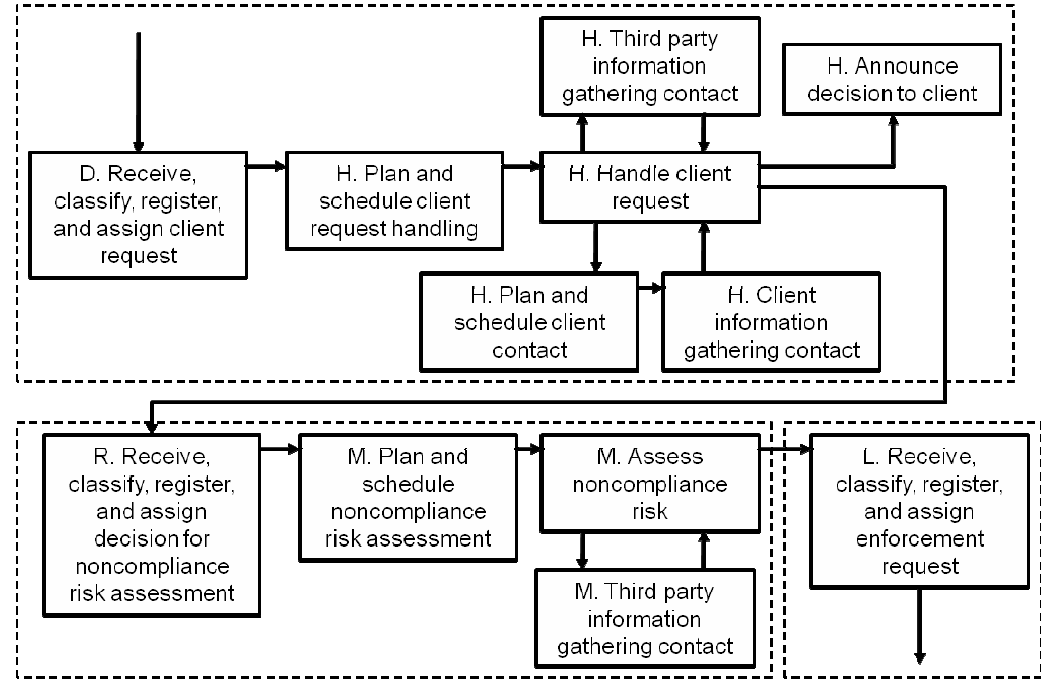
Figure 3: Repetition of the same generic task design patterns in business process